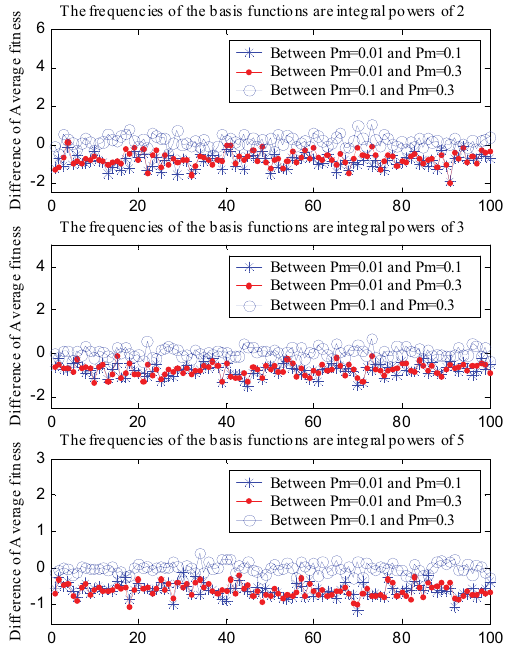
Fig. 6. The differences of the average fitness of the best solutions found in the 20 rounds of cal- culation between each pair of the GAs with dif- ferent mutation rates P m for the fitness functions ( a i sin ( 2 π m i − 1 x + ϕ i )+ | a i | ) , where the settings are ∑ n B i = 1 ( m = 2 , n B = 51 ) under the base-2 encoding, ( m = 3 , n B = 32 ) under the base-3 encoding, and ( m = 5 , n B = 22 ) under the base-5 encoding, respectively. For each setting of ( m , n B ) , there is no difference be- tween the performance with Pm = 0 . 1 and that with Pm = 0 . 3 in the statistical sense, but they both signifi- cantly better than that with Pm = 0 . 01